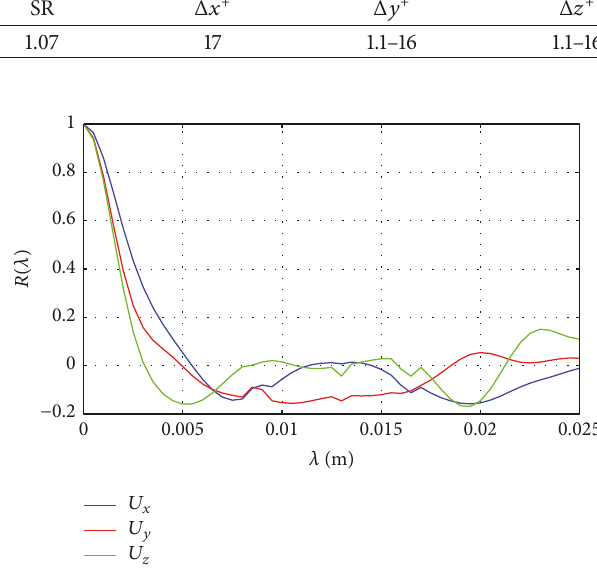
Figure 4: The time averaged autocorrelation function of the instantaneous velocity components taken along the central line of the inlet